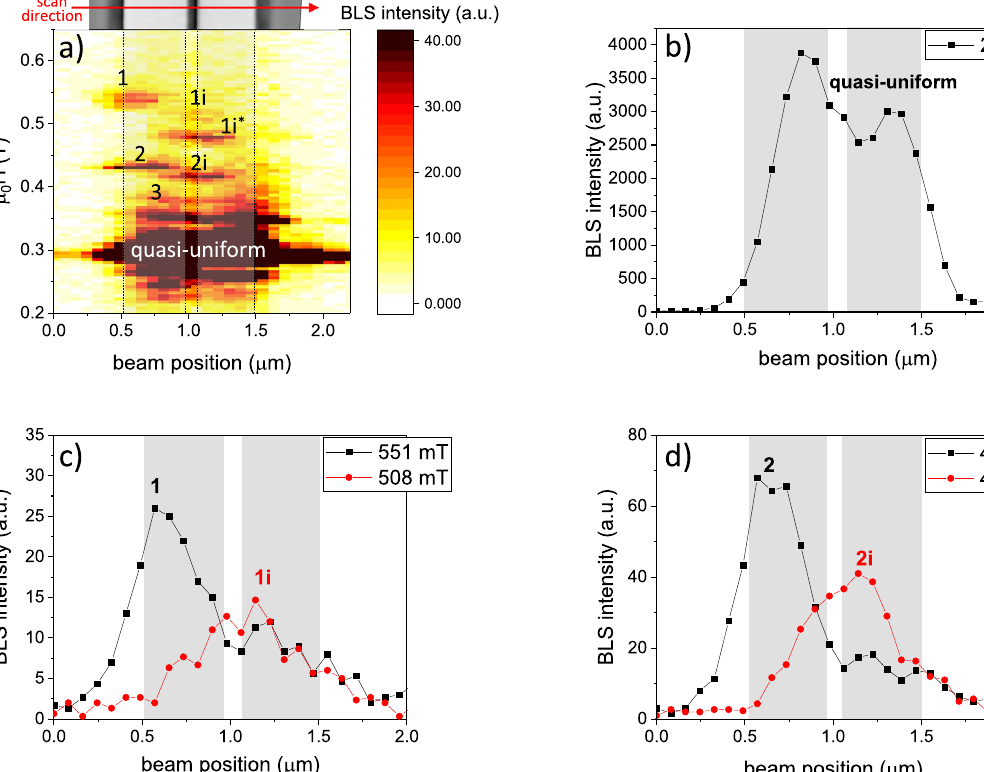
Figure 4. ( a ) BLS intensity map measured on the HIM-cut strip with 100 nm gap as a function of the in-plane bias field applied perpendicular to the strip’s long axis and for different laser beam positions across the sample (denoted by the red arrow in the top inset). The measurements were performed at an excitation frequency of 14.059 GHz. Rectangles on the map are guides to the eye to indicate the strip edges. ( b ) BLS intensity as a function of the beam position measured for µ 0 H = 295 mT, corresponding to the quasi-uniform µ FMR mode. ( c , d ) BLS intensity vs. beam position measured for the fields corresponding to ( c ) the modes 1 and 1i and ( d ) the modes 2 and 2i localized at the outer (black circles) and the inner (red squares) edges of the cut strips, respectively. The shaded rectangles in ( b – d ) denote the positions of the strip cross sections with respect to the scanned modes correspond to the mode 1, localized at the outer edge of the strip, and mode 1i, localized at the inner edges of the strips. The same analysis allows for classifying the modes at µ 0 H = 435 mT and µ 0 H = 420 mT as modes 2 and 2i, respectively [see Fig. 4d]. In addition, one can clearly note the gradual shift of the BLS intensity of the localized modes towards the central region of the strip, in accordance with the simulated mode profiles of Fig. 3e. Despite limited spatial resolution of the BLS microscopy [taking into account the positioning stage step of ∼ 80 nm (for this particular experiment) and the laser beam spot size of ∼ 350 nm (see section “Methods”], a comparison of µ FMR and BLS with the corresponding simulated mode profiles allows for an unambiguous classification of the visualized resonances. Notably, the modes 1 i ∗ and 1 i ∗∗ , present in the µ FMR spectra, are also detected by the BLS microscopy [see Fig. 4a]. The spatial distribution of their BLS intensity signal indicates that these modes are localized at the inner edges of the strips. Therefore, the appearance of these modes is attributed to the inner edges asymmetry of the cut strips (including a non-uniform separation over the thickness and side wall slope), as explained above in section Dynamical modes definition. Interestingly, the modes localized at the outer edges are detected only at one side of the strip. This asymme- try might be explained by a non-homogeneous rf field distribution across the strips due to the slight off-center position of the strips in the microresonator. Therefore, opposite strip edges are exited with different rf-field amplitudes leading to the spatial asymmetry of the BLS intensity map. Additionally, the (cid:31) -shaped antenna has a ∼ 2 µ m opening to allow for the rf current flowing through the resonator [see Fig. 1a]. Hence, the strip edge closer to this opening is excited with different amplitude as compared to the opposite edge, and the correspond- ing dynamical signal falls below the detection threshold. One has to note that the slight discrepancies between the resonance fields detected by µ FMR and BLS meas- urements can be attributed to different scales of the experiments. Whereas in the inductive µ FMR measurements a volume-averaged magnetic signal is detected, the BLS microscopy is a purely local technique probing the dynamics in the small area illuminated by the laser spot. In that respect, laser-induced heating of the sample may also contribute to the observed resonance fields shift due to locally modified magnetic parameters. In addition,